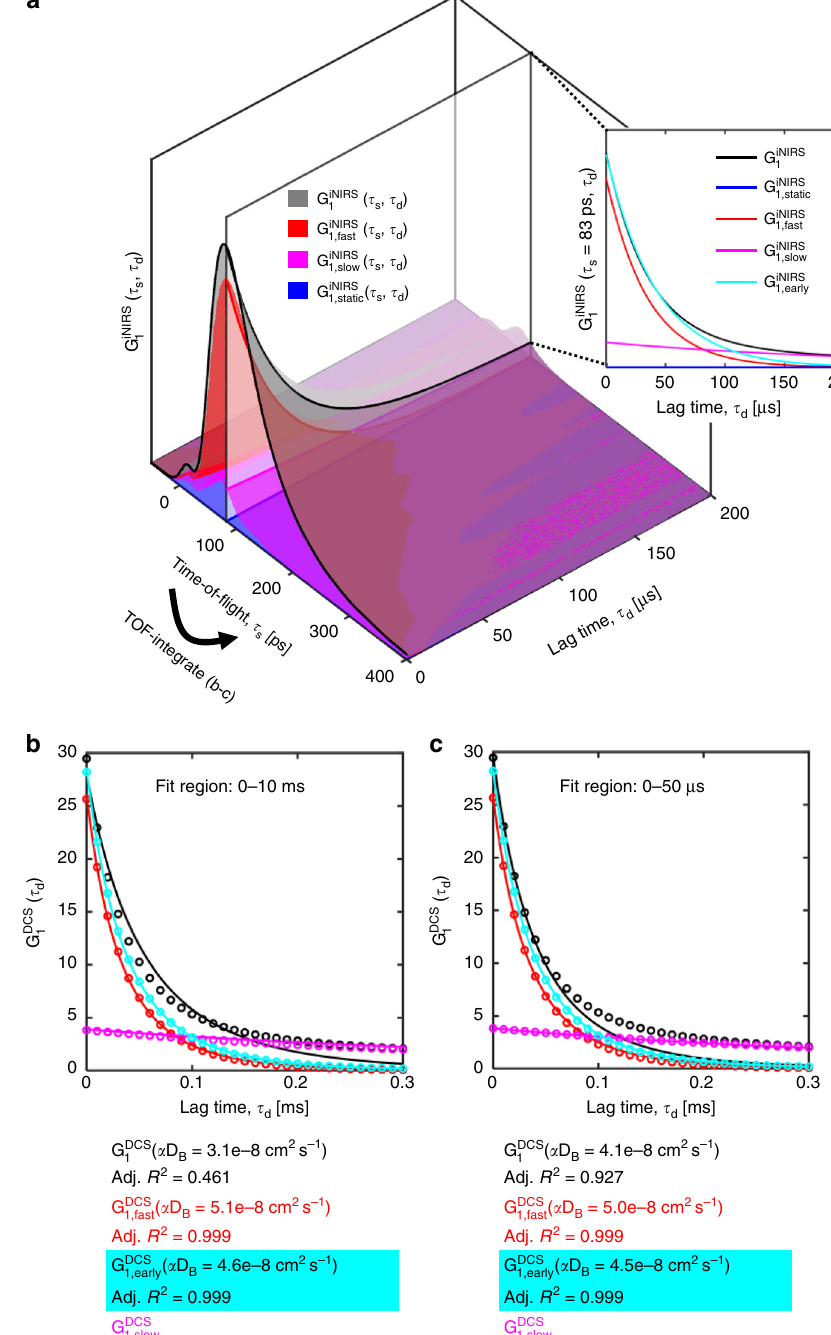
Fig. 6 Deconstruction of DWS/DCS with iNIRS. a in vivo iNIRS TOF-resolved fi eld autocorrelations, or individual components thereof, can be integrated in TOF to generate DWS/DCS-like autocorrelations. For TOF-integrated DWS/DCS-like autocorrelations, G DCS DCS theory results in a poor fi t ( b ). Fitting early time lags, where the cumulant approximation is valid, results in a considerably higher adjusted R 2 value, but the fi t diverges from the data at large time lags ( c ). On the other hand, integrating just the iNIRS fast component (red) or the iNIRS early time lag single exponential fi t (cyan), yields autocorrelations in better agreement with DWS/DCS theory across time lags and adjusted R 2 approaches 1 regardless of fi t region ( b – c